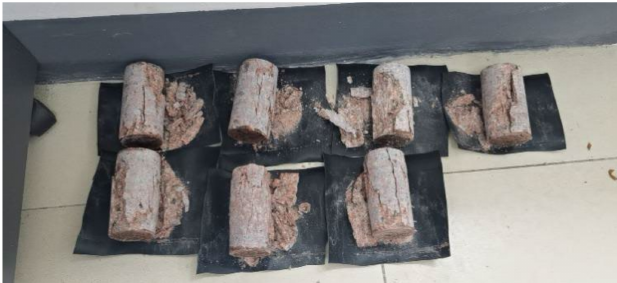
Figure 10. Compression results of specimens. Table 2. Rock material coefficient